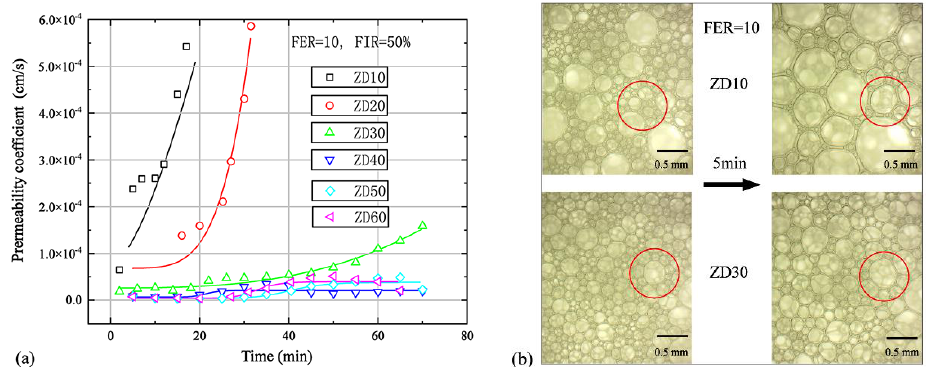
Figure 5. E ff ect of T hl on conditioned sand permeability. ( a ) Change in conditioned sand permeability Figure 5. The e ffect of hl T on conditioned sand permeability. ( a ) Change in conditioned sand coe ffi cient with time under di ff erent foam products, and ( b ) the bubble image of ZD10 and ZD30 foam permeability coefficient with time under different foam products, and ( b ) the bubble image of ZD10 sizes within 5 and ZD30 foam sizes within 5 min.